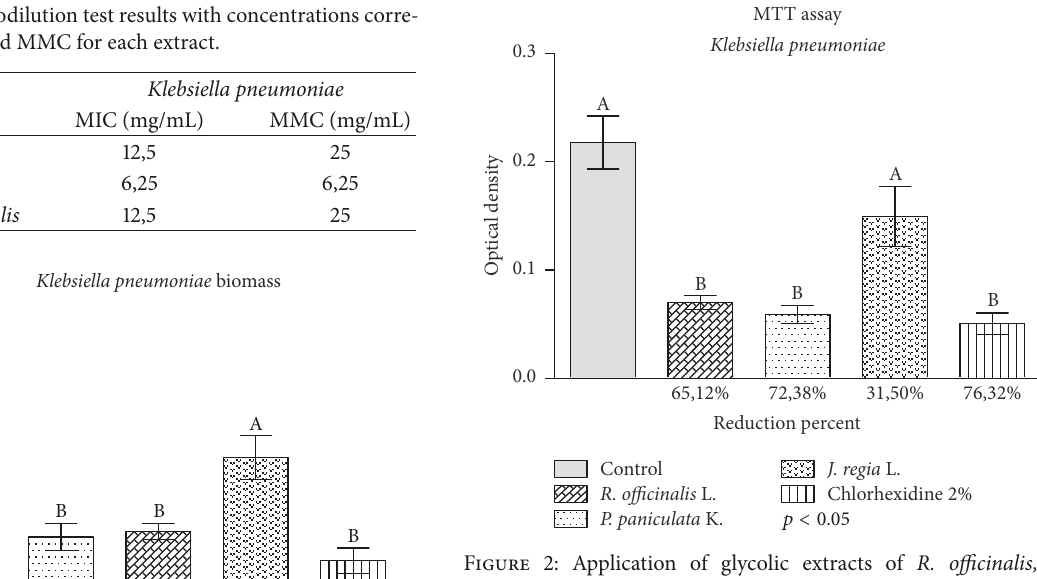
Figure 2: Application of glycolic extracts of R. officinalis, P paniculata, and J. regia at concentration of 200 mg/mL against K. pneumoniae biofilm during 5 min. Control group received 0.9% NaCl during 5 min. The results indicate the mean values of cell viability reduction in percentage of each extract compared to the control group. Letters (A or B) express the comparison of groups in statistical analysis ( 𝑝 < 0.05